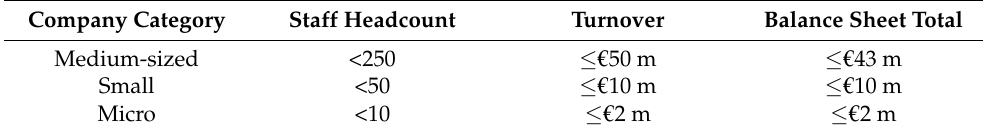
Table 3. Categorization of SMEs. Company